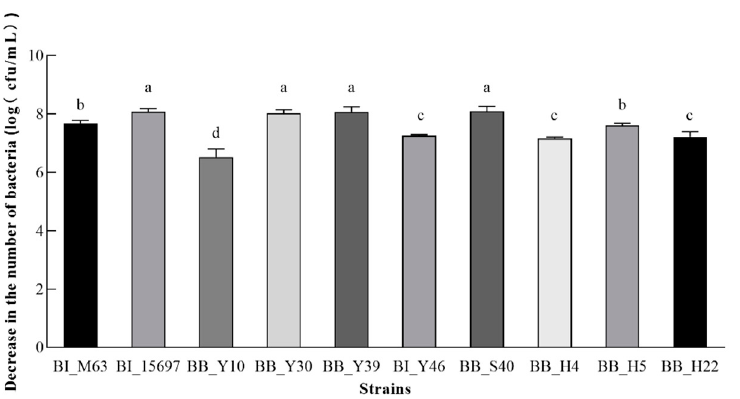
Figure 4. Bile salt tolerance of screened bifidobacteria. The decreased numbers of strains after 30 min of treatment by 0.2% porcine bile salts were used express the bile salt tolerance. Different lowercase letters represent significant differences among different strains.